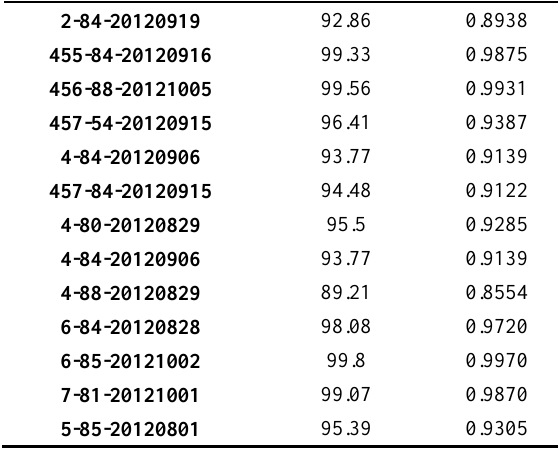
Table 1. The overall accuracy and Kappa coefficient of HJ 1A/B images using MLC